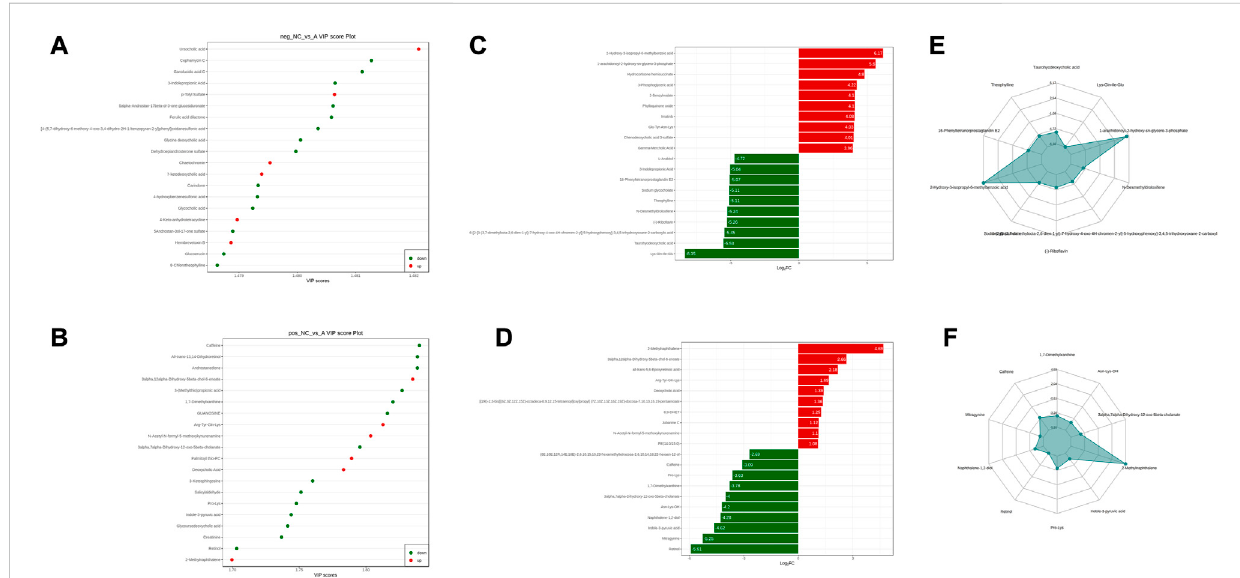
FIGURE 5 NC vs. group A differential metabolite screening. (A) top 20 potential differential metabolites with VIP ≥ 1 under anionic conditions; (B) top 20 potential differential metabolites with VIP ≥ 1 under cationic conditions; (C) top 10 differential metabolites with up- and downregulated ploidy change valuesunderanionicconditions; (D) top10differentialmetaboliteswithup-anddownregulatedploidychangevaluesundercationicconditions; (E) radar plot under anionic conditions selectively showing ten representative differential metabolites with change fractions; (F) radar plot under cationic conditions selectively showing ten representative differential metabolites with change fractions.